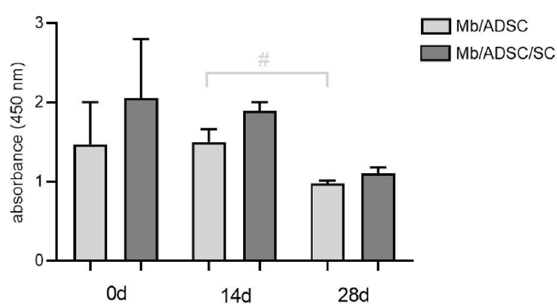
Figure 7. Cell viability on PCL-collagen I-nanofibers determined with wst-8-assay. Absorbance at a wave length of 450 nm is expressed as mean ± standard deviation. Cell viability decreased from 14 to 28 days in Mb/ADSC (# p < 0.05, repeated measures ANOVA with Tukey‘s multiple comparison test).